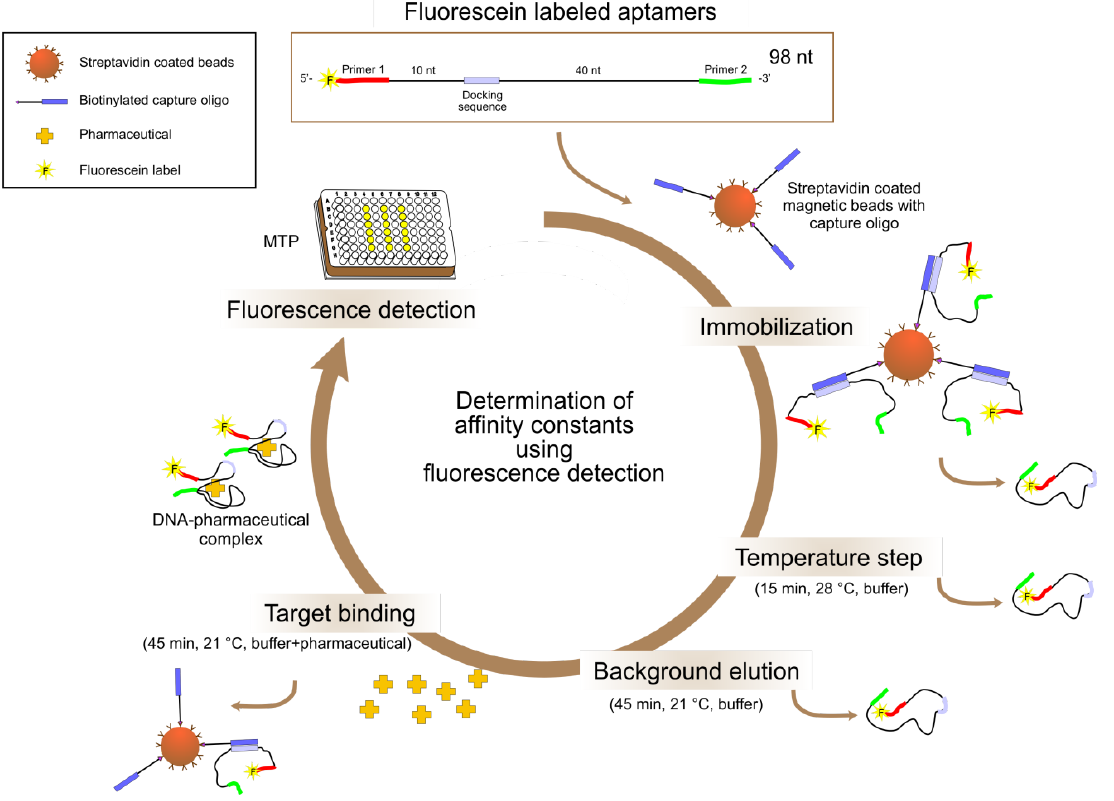
Figure 3. Schematic representation of the bead based assay using fluorescence